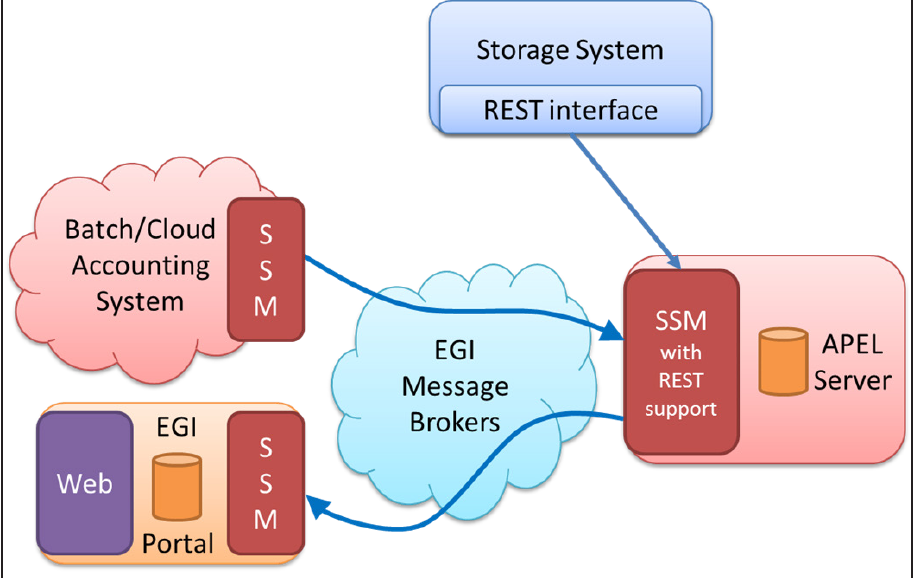
Fig. 2. The updated accounting system. In this case, the Storage System is Onedata. The SSM on the APEL server has been modified to add REST support. Existing accounting batch and cloud accounting sources shown in a simplified